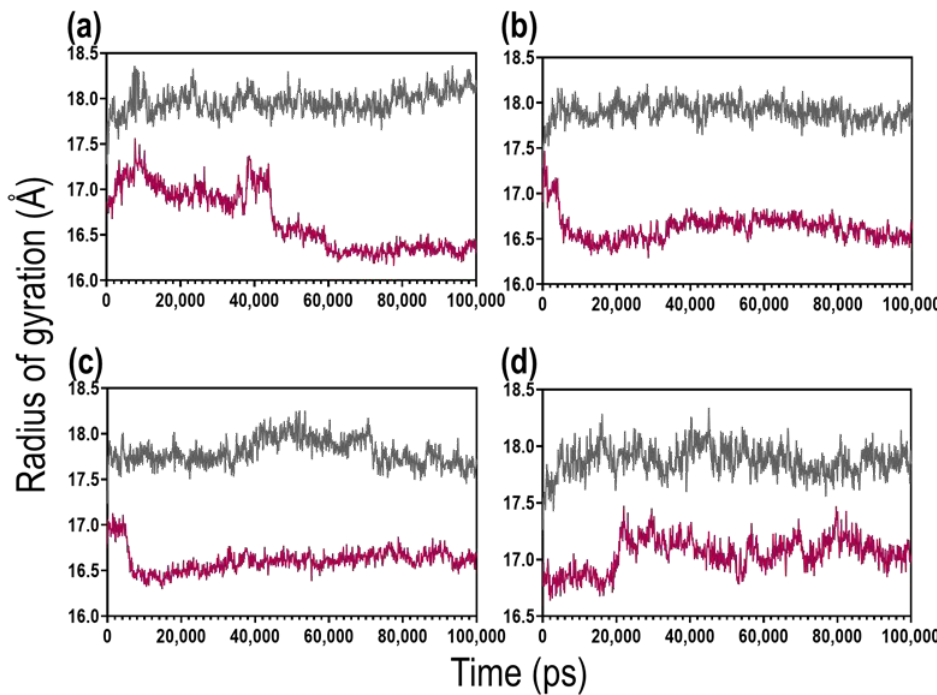
Figure 7. The radius of gyration (Rg) of the C α atoms of KpNNAT. KpNNAT apo (gray) and KpNNAT-ATP complex (Purple) were analysed with ( a ) no metal ( b ) Mg 2+ ( c ) Ca 2+ and ( d ) Zn 2+ over 100 ns simulation time. The Rg of KpNNAT apo systems are comparable amongst the different metals ions. However, a decrease in the Rg of the protein was observed upon ATP binding. The plots were generated using GraphPad Prism.